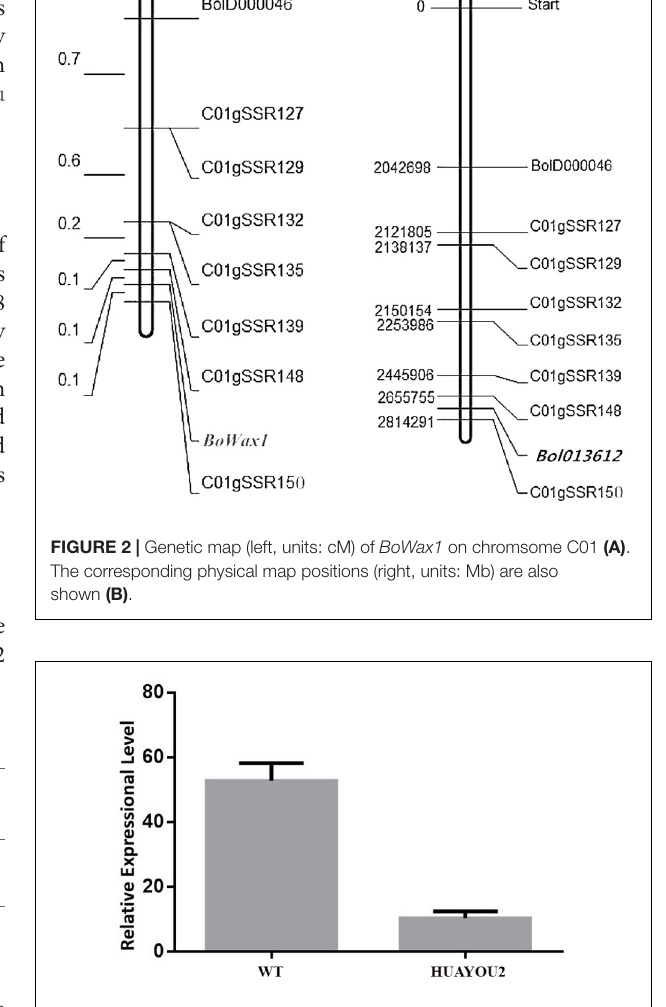
FIGURE 3 | Expression level (Y axis) of gene Bol013612 in HUAYOU2 and WT. qPCR analysis showing expression level in HUAYOU2 is significantly decreased compared with that of the WT. Standard errors are also